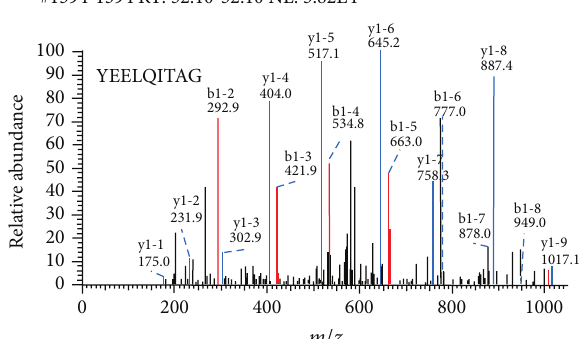
Figure 4: Representative MS/MS spectrum of the peptide of keratin 1.